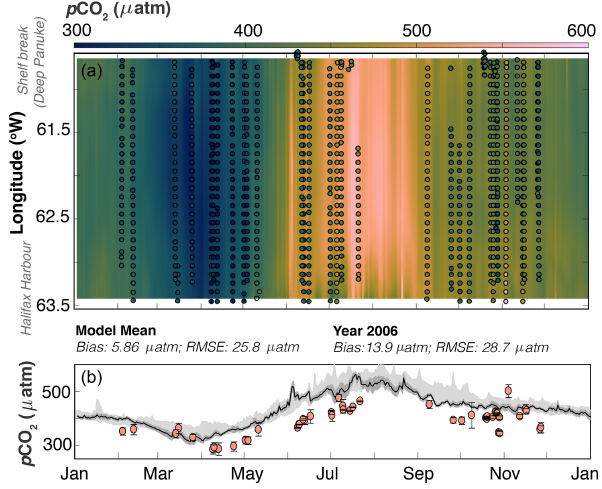
Figure 3. Model–data comparison along the Atlantic Condor tran- sect. Panel (a) shows p CO 2 (in colour) evolving over time ( x axis) along the transect (longitude on the y axis; Halifax Harbour to shelf break). The background is the model average p CO 2 along the tran- sect, and the points are the Atlantic Condor data binned into 0.1 ◦ longitudinal bins. Panel (b) shows the average p CO 2 along the tran- sect ( y axis) as it evolves over the seasonal cycle ( x axis). The line is year 2006 from the model averaged across the transect, the dark grey shaded area is the standard deviation, and the light grey shaded area is the min–max p CO 2 along the transect from 2006–2014. The points are the average, and the error bars are standard deviation of observational p CO 2 across each transect. The Atlantic Condor ob- servations are mapped to year 2006 in both panels using the atmo- spheric trend in p CO 2 . RMSE: 28.7µatm; bias: